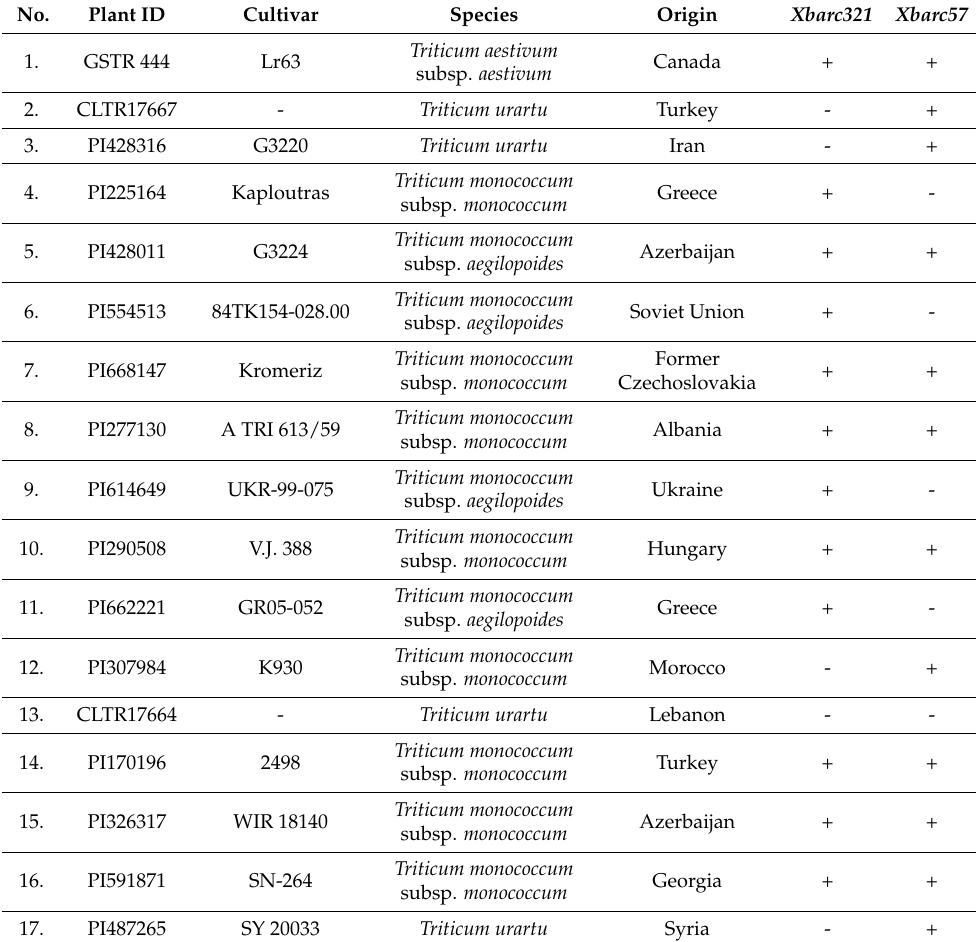
Table 1. Origin and presence of Xbarc321 and Xbarc57 markers linked to Lr63 locus in tested diploid wheat. “+”—presence of marker; “-”—absence of